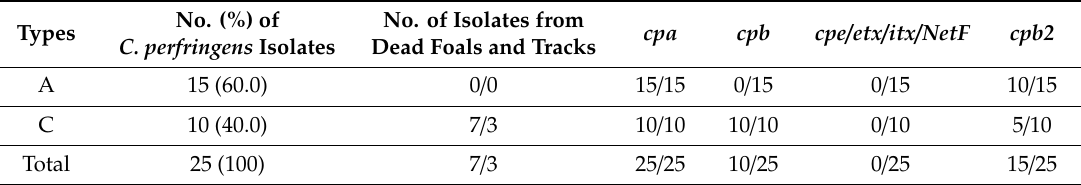
Table 2. Distribution of cpa, cpb, cpe / etx / itx / NetF, cpb2 genes and types among 25 Clostridium perfringens isolated from horses and